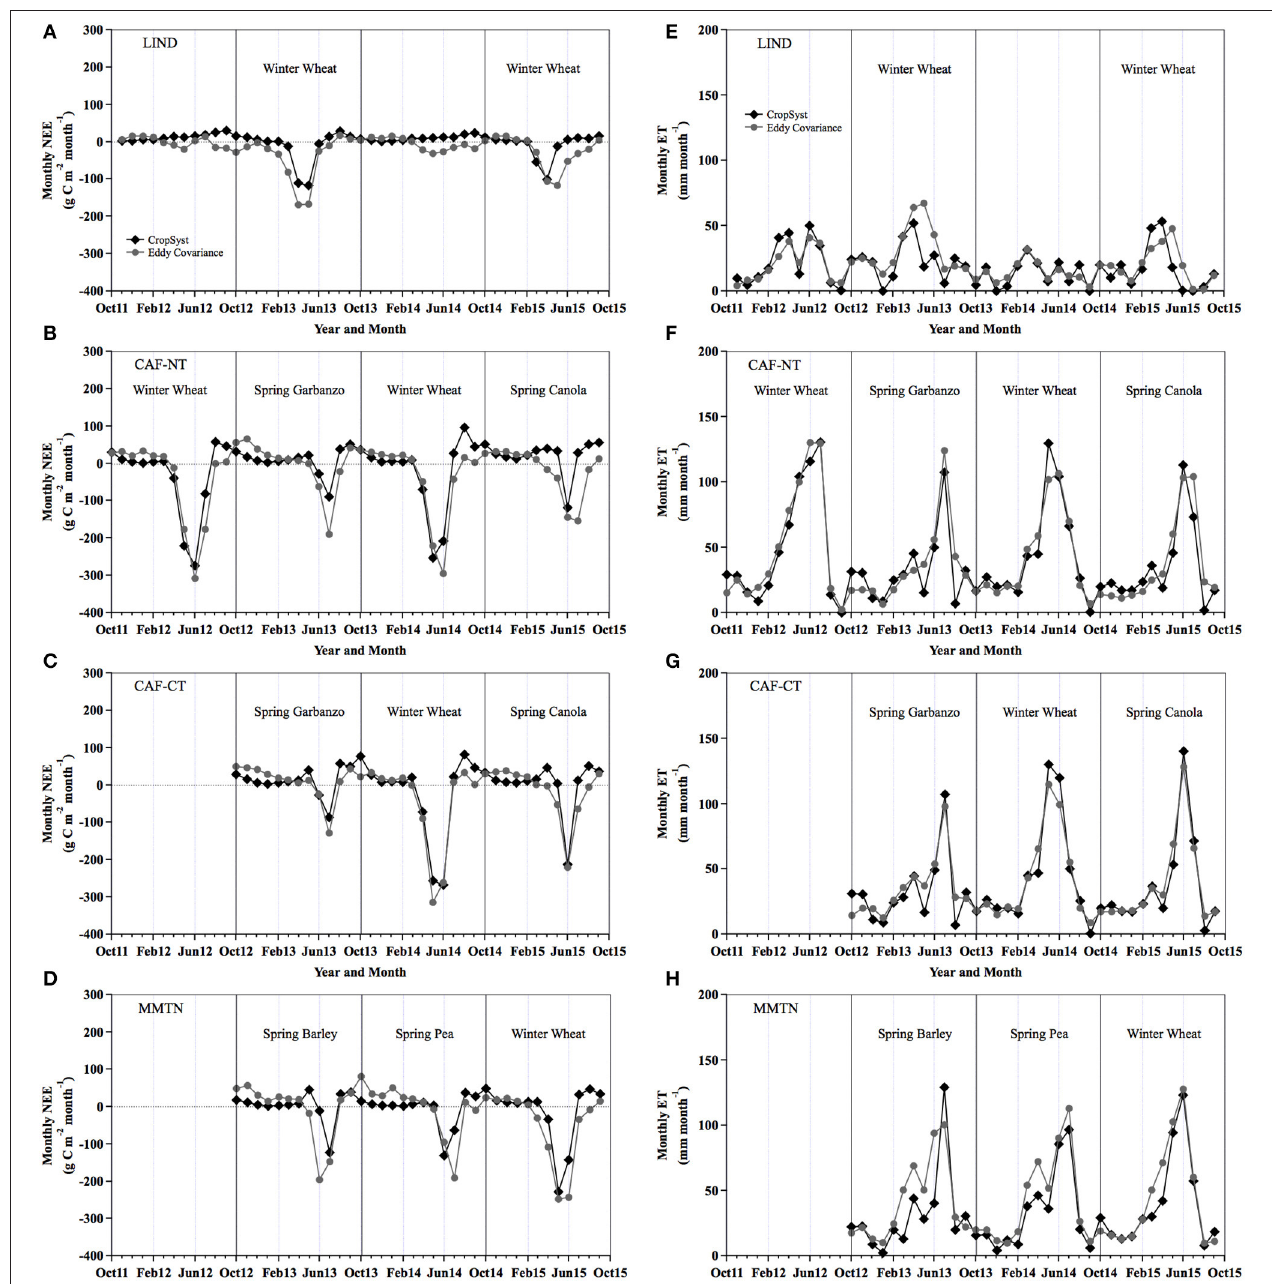
FIGURE 3 | CropSyst and eddy covariance monthly net ecosystem exchange of CO 2 (NEE, A–D ) and evapotranspiration (ET, E–H ) at four sites from October 2011 to September 2015.